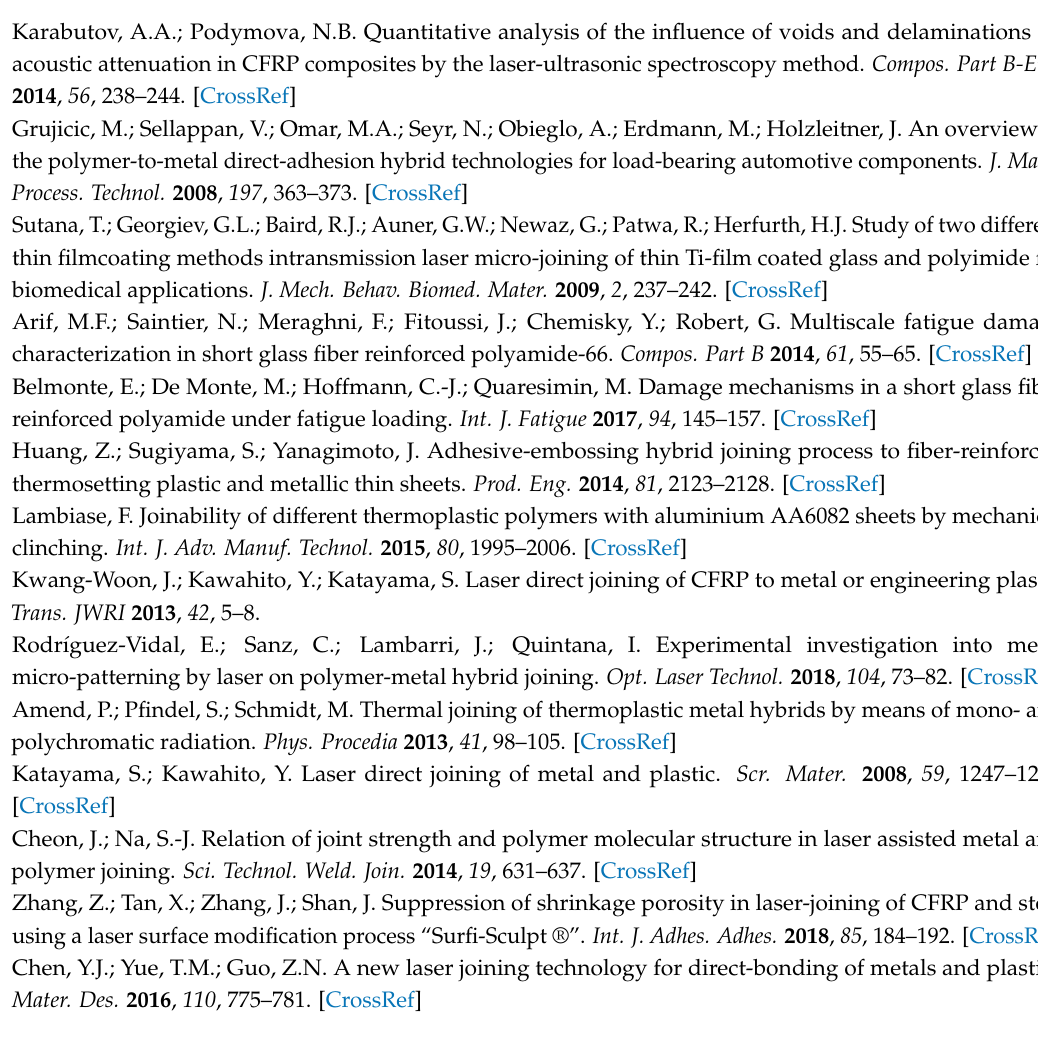
Figure S1: The created grooves on Ti6Al4V surface with structure density of 25% ( a ), 42% ( b ), 58% ( c ), and 75% ( d ), respectively; Figure S2: Cross-sections of LAMP produced joints with structure density of 25% ( a ), 42% ( b ), 58% ( c ), and 75% ( d ), respectively; Figure S3: Cross-sections of the modified laser joining method